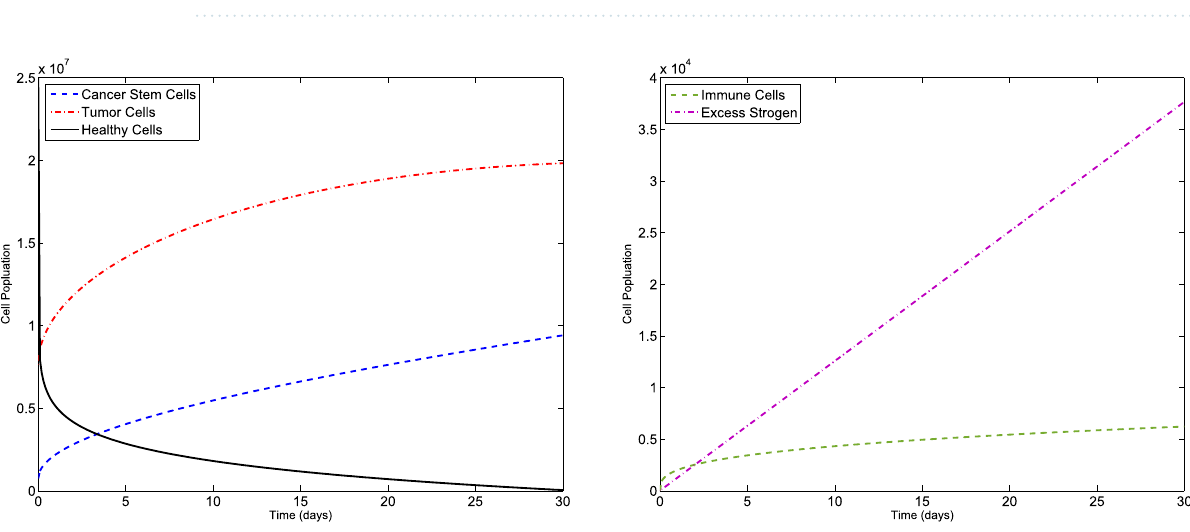
Figure 2. Evolution of { C ( t ) , T ( t ) , H ( t ) , I ( t ) , E ( t ) } vs time for the F-BCCM with m 1 = 2 , m 2 = m 3 = m 4 = 3 ,